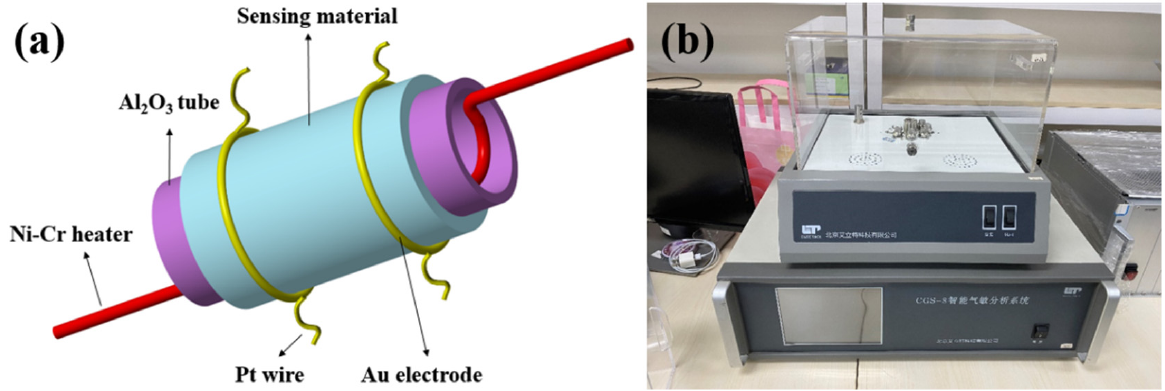
Figure 1. ( a ) Schematic diagram of fabricated gas sensor; ( b ) DGL-III Gas and Liquid Distribution System.